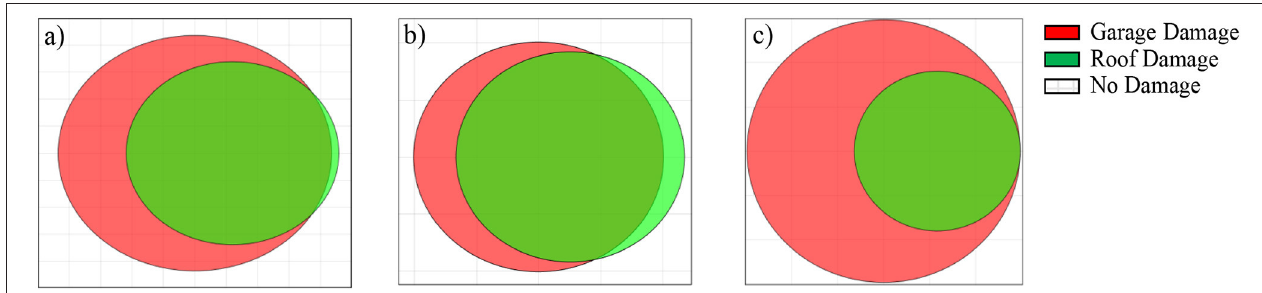
FIGURE 3 | Example of garage door and roof structure damage Venn diagrams in (a) Moore, OK ( N = 397), (b) Joplin, MO ( N = 540), and (c) Hurricane Ike ( N = 137).